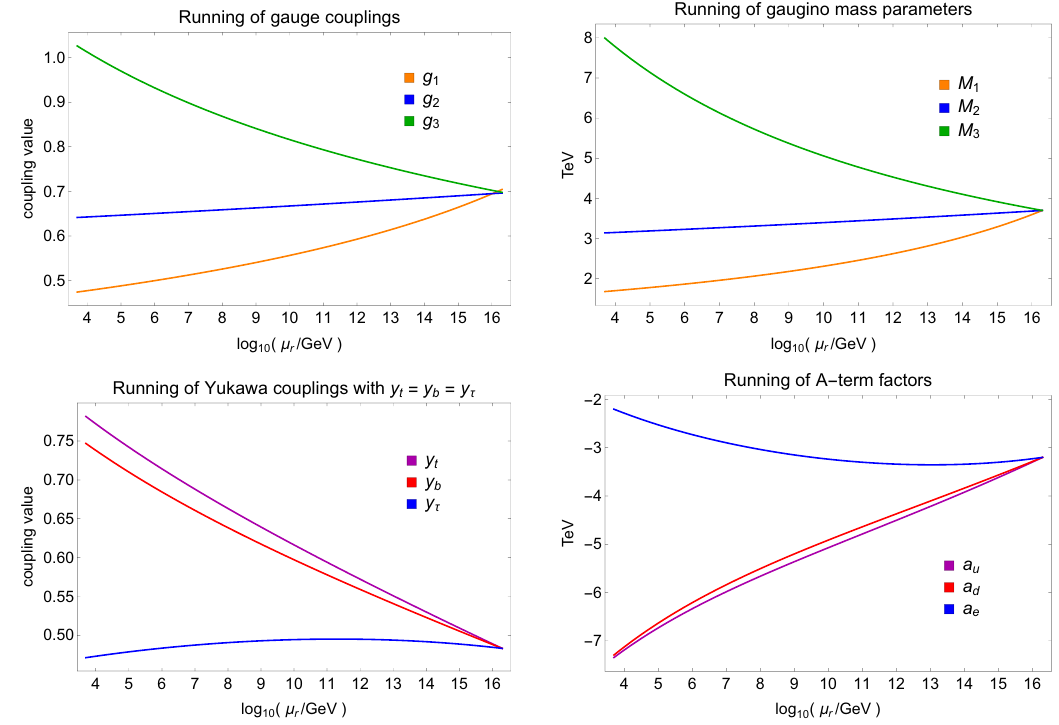
Figure 1 . The RGE running between M SUSY and M GUT for the example point in eq. (3.11){(3.20) of the the gauge couplings (top left), gaugino mass parameters (top right),the 3rd family Yukawa couplings (bottom left), and the A -term proportionality factors (bottom